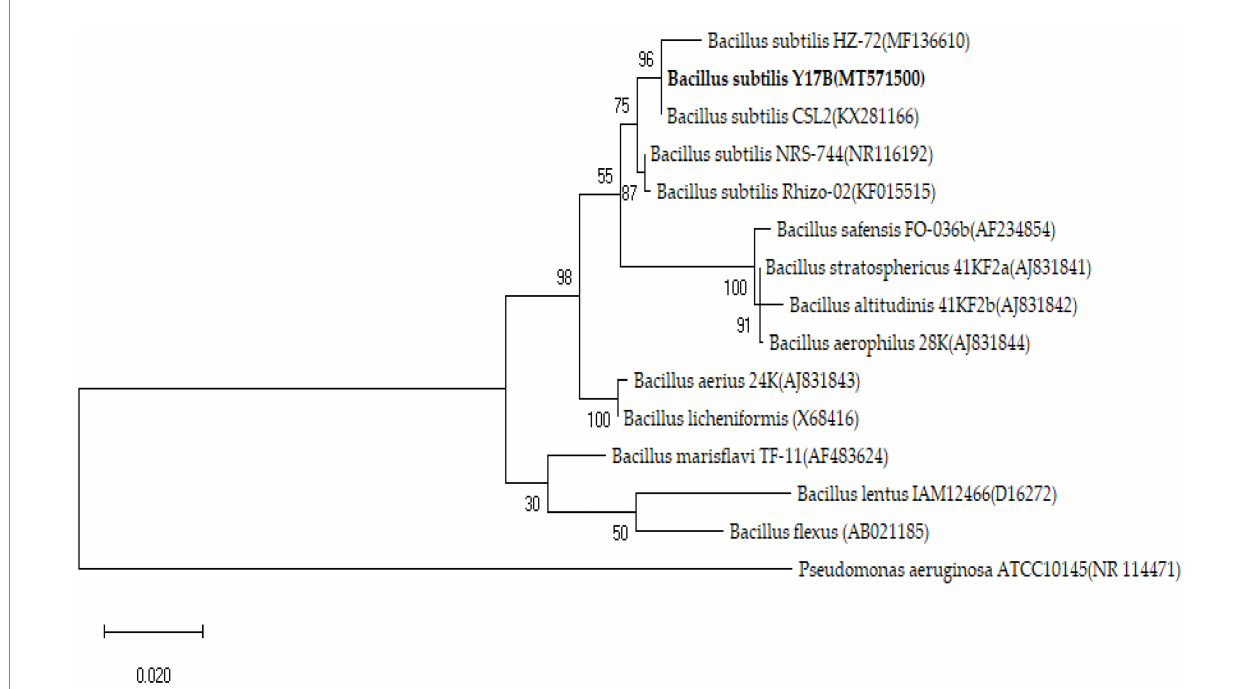
FIGURE 1 Maximum likelihood phylogenetic tree of the tested bacteria based on the Taimura Nei model. The scale bar represents 0.02 nucleotide substitutions per nucleotide position. The numbers on the nodes are bootstrap values inferred from 1,000 replicates. The reference isolates used in this study were as follows: B. aerophilus 28 K (GenBank ID. AJ831844), B. altitudinis 41KF2b (AJ831842), B. stratosphericus 41KF2a (AJ831841), B. licheniformis (X68416), B. aerius 24 K (AJ831843), B. subtilis HZ-72 (MF136610), B. safensis FO-036b (AF234854), B. subtilis Rhizo-02 (KF015515), B. subtilis CSL2 (KX281166), B. flexus (AB021185), B. marisflavi TF-11 (AF483624), B. lentus IAM12466 (D16272), B. subtilis NRS-744 (NR116192), B. licheniformis (X68416), and Pseudomonas aeruginosa ATCC10145 (NR_114471).